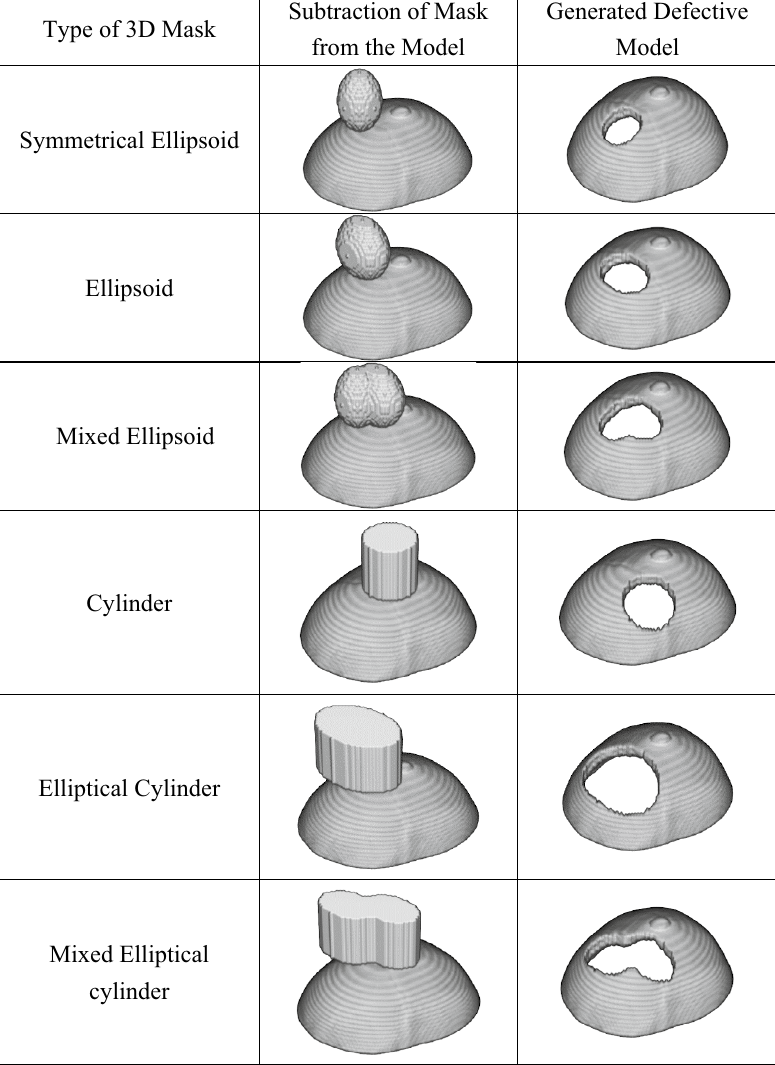
Figure 6. Various types of 3D masks are used to generate defects on the cranial model to train the proposed deep learning